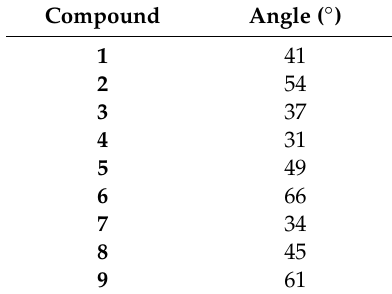
Table 6. Dihedral angles of the nitro group relative to the benzene calculated using Chem3D Ultra 10.0.